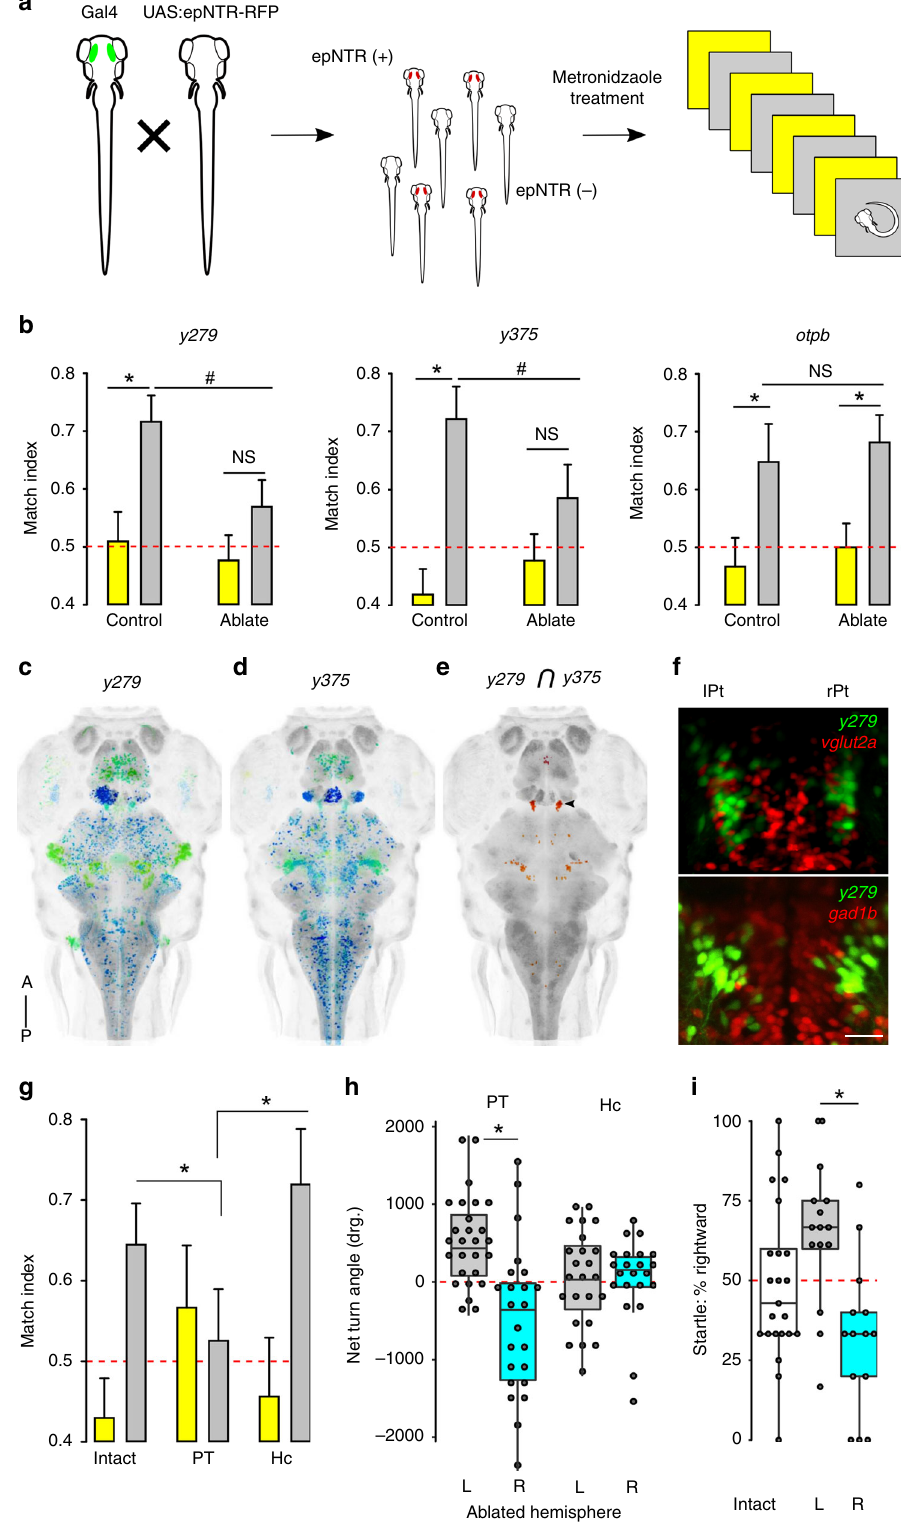
(Supplementary Fig. 2j). These results establish that a subset of PT neurons fi re in response to changes in illumination, remain active on a timescale consistent with the duration of motor asymmetry during dark-induced circling behavior, and potentially receive direct photic input from the